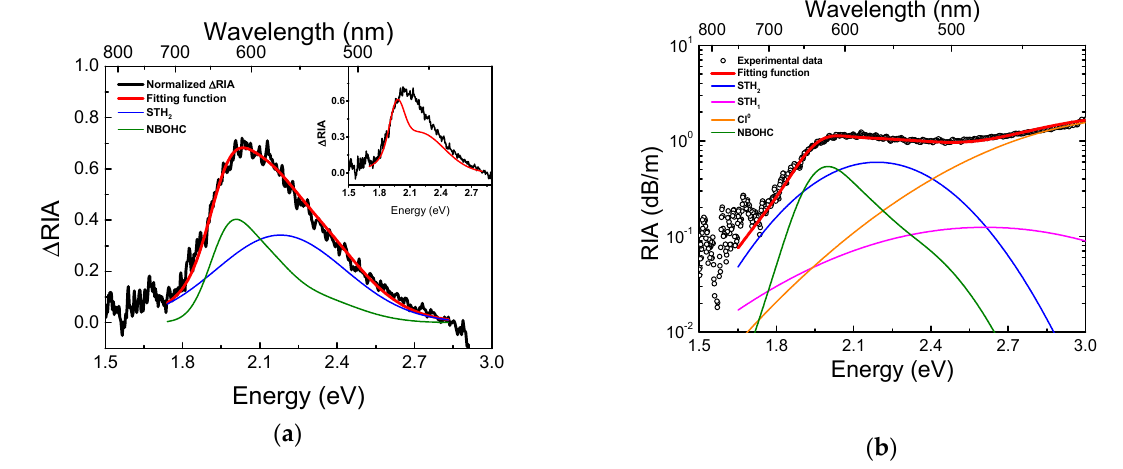
Figure 7. ( a ) Fitting function of the difference between the normalized RIA of the medium - and the low -OH samples, taking into account the NBOHC model of [39]. The inset shows the attempt to fit the Δ RIA with the NBOHC considered as a single Gaussian band. ( b ) Fitting function of the RIA at 300 kGy of the medium -OH sample. Table 2. Best-fit parameters for the RIA at 300 kGy of the three tested fibers.